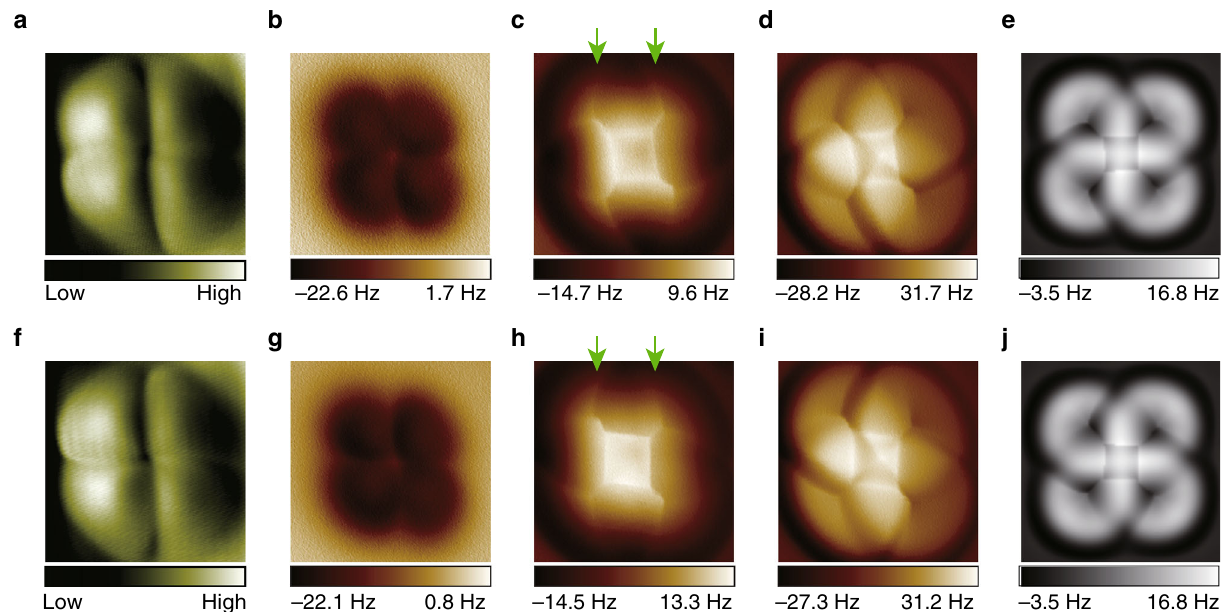
Fig. 3 Experimental and simulated AFM images of two degenerate water tetramers with a Cl-terminated tip. a , f Derivative STM images of the water tetramers with clockwise and anticlockwise hydrogen-bonded loops, respectively. Set point: 10 mV and 50 pA. b – d , g – i Corresponding Δ f images. All the images were obtained on the same tetramer (switched) with the same Cl-tip. The tip heights are 30 pm ( b , g ), − 120 pm ( c , h ), − 120 pm ( d , i ). The oscillation amplitudes are 40 pm ( b , g ), 100 pm ( c , h ), 40 pm ( d , i ). The “ fork-like ” features are denoted by two green arrows in c and h . It is noted that the smallest tip heights for the AFM imaging here are at least 20 pm larger than those for the perturbative chirality switching in ref. 15 . e , j Simulated Δ f images with the oscillation amplitudes of 40 pm, which were obtained with a monopole (s) tip ( k = 0.5 N m − 1 , Q = − 0.25 e). The size of the images is 1.2 nm ×